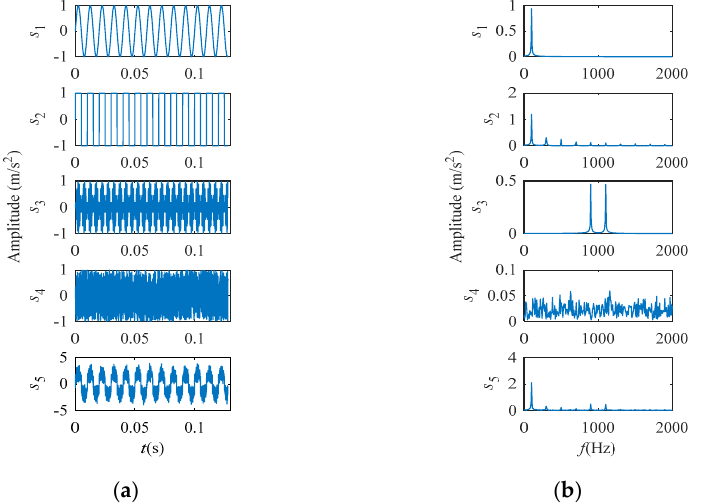
Figure 3. Simulation signals. ( a ) waveform of signals. ( b ) frequency spectrum. Calculate the CIM between the first four signals and s 5 , respectively. From (7), it can Y = , CIM = 0; CIM > 0, for other cases. Additionally, the greater the difference between the variables X and Y , the greater the CIM value. Set X in (6) to s 5 , set Y in (7) to s 1 , s 2 , s 3 , s 4 , respectively. Then four CIM values are displayed in Figure 4, it can be seen that the CIM between s 2 and s 5 is the smallest which can be ex- plained by the frequency spectrum (Figure 3b).